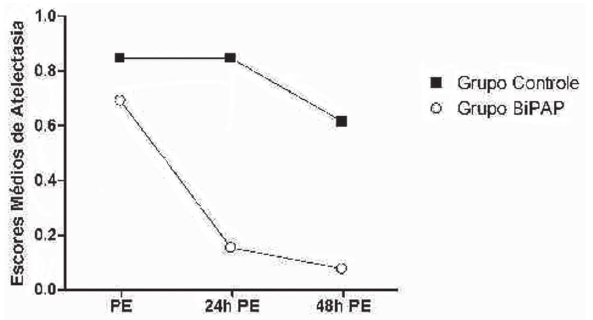
Fig. 5 – Evolução dos escores médios de atelectasia nos dias 1, 2 e 3 pós-operatórios, nos grupos Controle e BiPAP. PO: pós- operatório. (P=0,070 intragrupos, P=0,080 intergrupos)